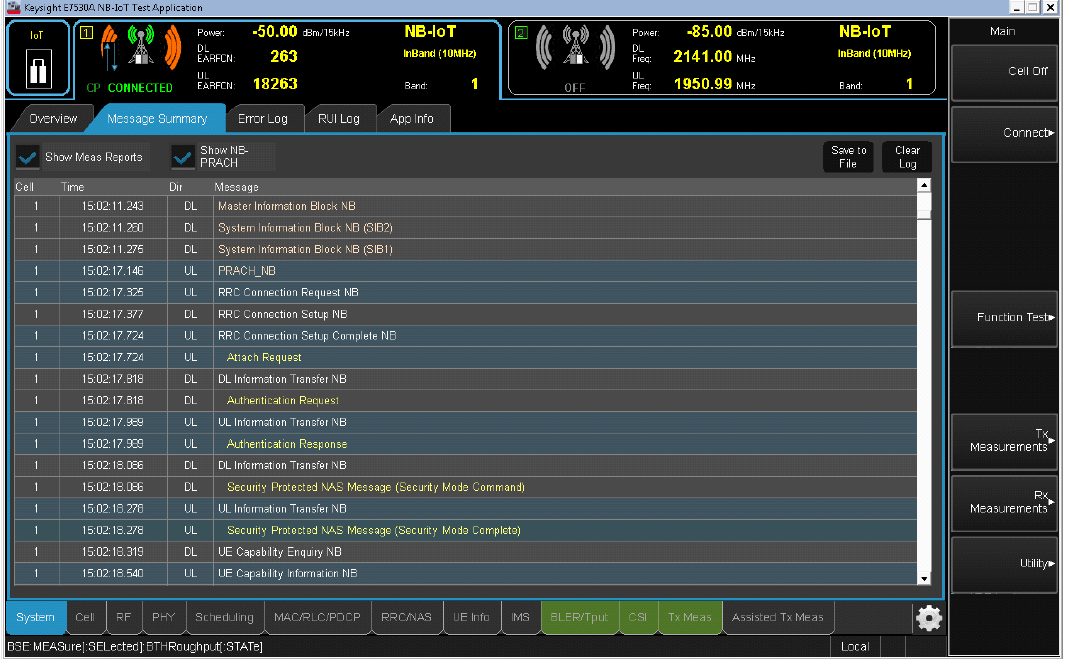
Figure 8. Control messages between the UE and the eNodeB emulator.